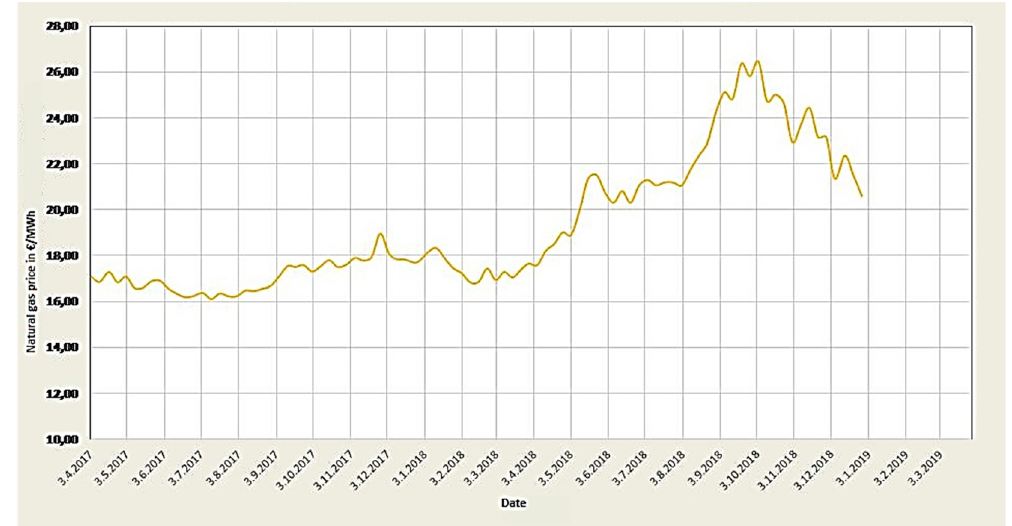
Figure 5. Gas end user prices on the stock market—the index PXE (Source: [33]).